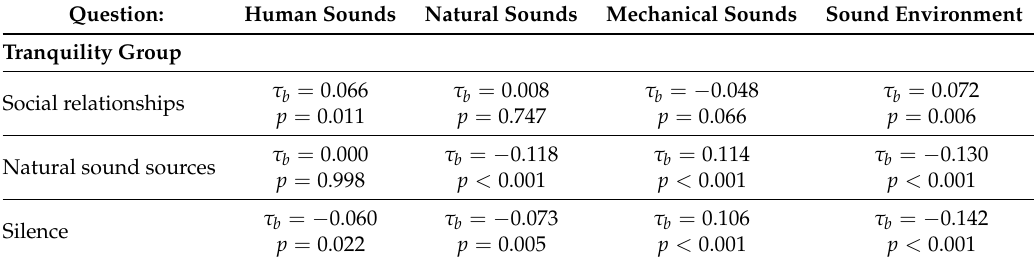
Table 2. Rank correlation coefficients with significance values between participants’ responses to questions on hearing sounds (human, natural and mechanical) and belonging to a specific tranquility group. In the last column, the same is shown for the question on the quality of the sonic